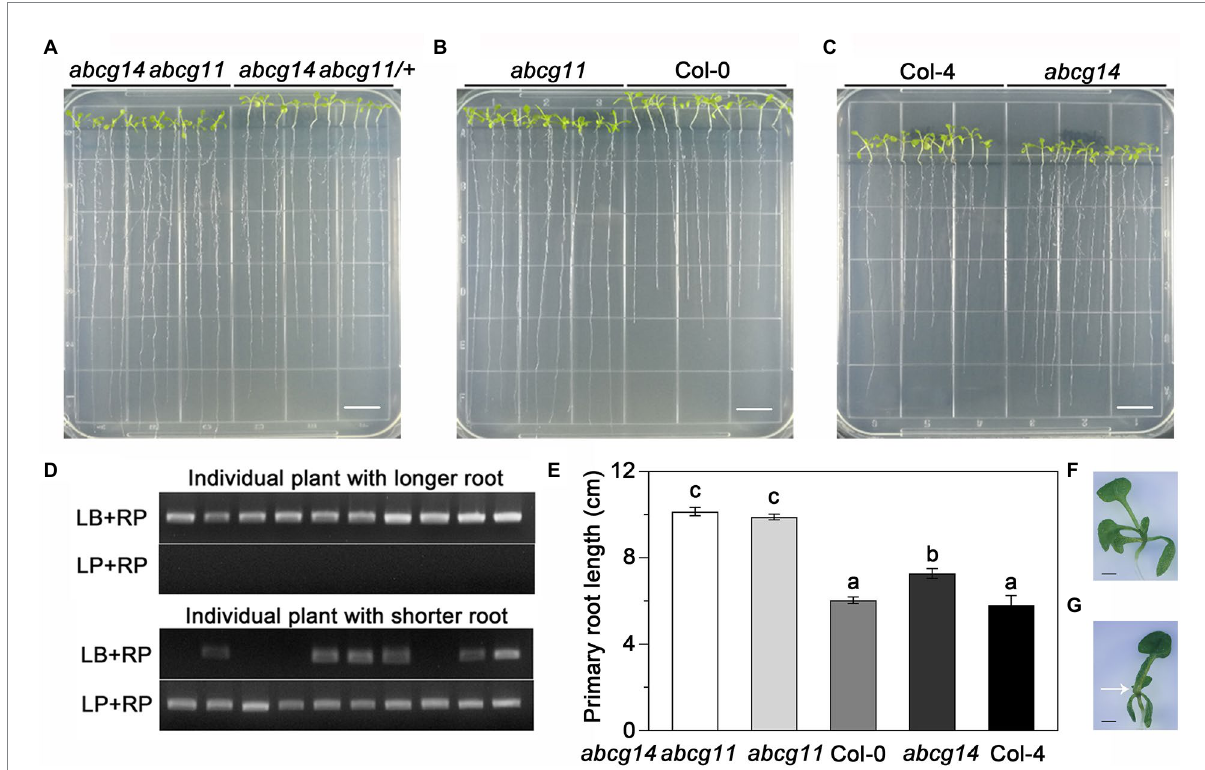
FIGURE 8 The abcg14 abcg11 double knockout mutant exhibits a similar root length phenotype as the abcg11 single mutant. (A–C) Photographs of seedlings grown vertically on MGRL medium for 12 d under short-day conditions (8 h light/16 h dark). Scale bars, 1 cm. Note that seedlings in (A) were rearranged according to their primary root length prior to the photograph. (D) Genotyping results of abcg14 abcg11/+ and abcg14 abcg11 seedlings shown in (A) . (E) Primary root length of the seedlings shown in (A–C) . Data are shown as means ± SE ( n = 30). Different letters represent significant differences, as determined by one-way ANOVA ( p < 0.05). (F,G) Photographs of abcg14 (F) and abcg14 abcg11 (G) seedlings. The arrow points to a site of organ fusion. Scale bars, 1.0